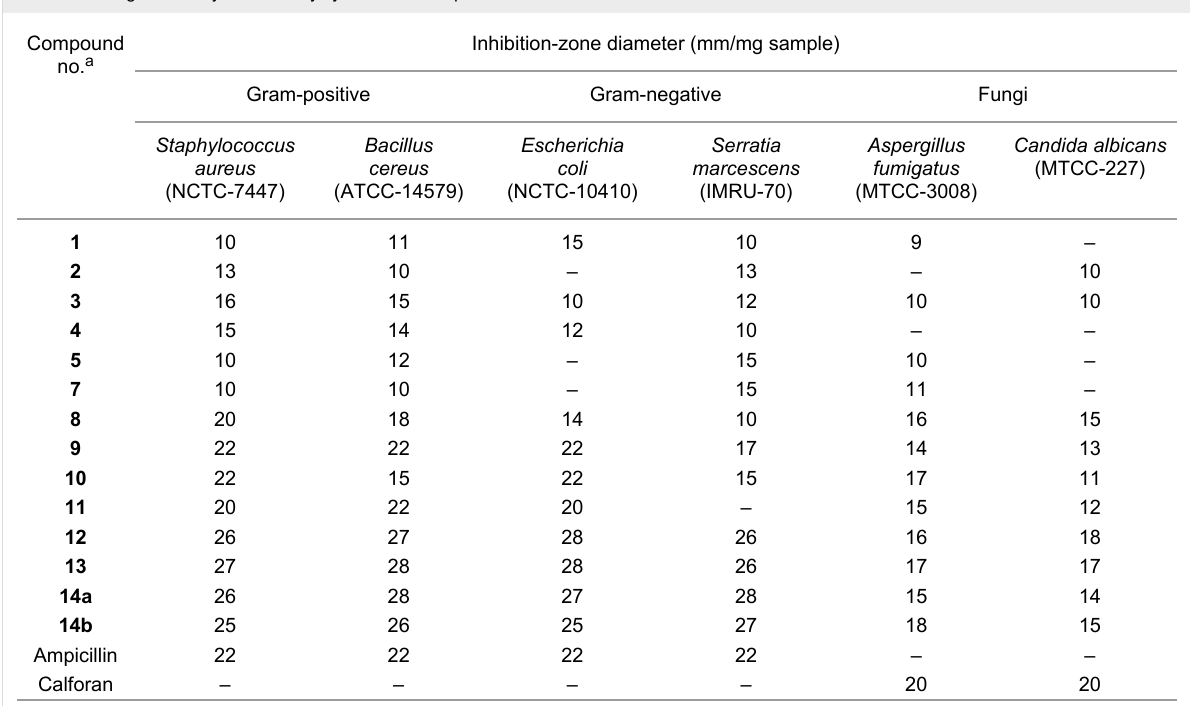
Table 1: Biological activity of the newly synthesized compounds. Compound no.